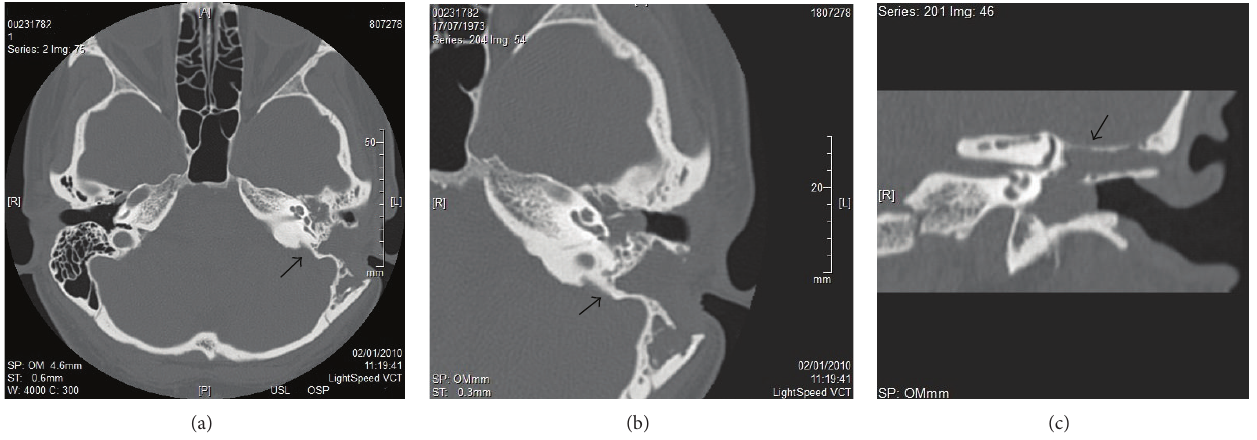
Figure 2: CT imaging (a) with axial (b) and coronal (c) scans demonstrated an irregular, hypodense, and expansile lytic lesion of the mastoid process of the left petrous bone extending to involve both the left medial mastoid and the middle ear, with a subtotal erosion of ossicular chain and a partial bone destruction of the “tegmen tympani” (see arrows). The mass did not appear to affect the semicircular canals, the canal of the facial nerve, and the internal auditory canal.